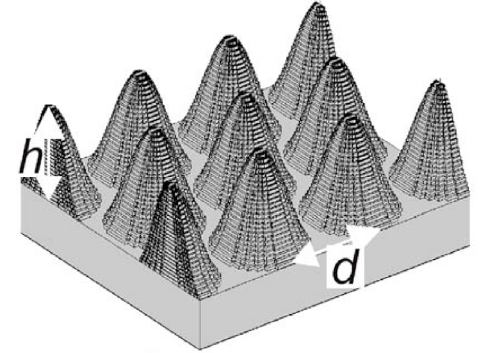
Figure 19. Stair step approximation of a periodic geometry as drawn in the commercially available rigorous coupled-wave analysis (RCWA) software, GD-Calc. Reprinted with permission from reference [72], Copyright 2006 AIP